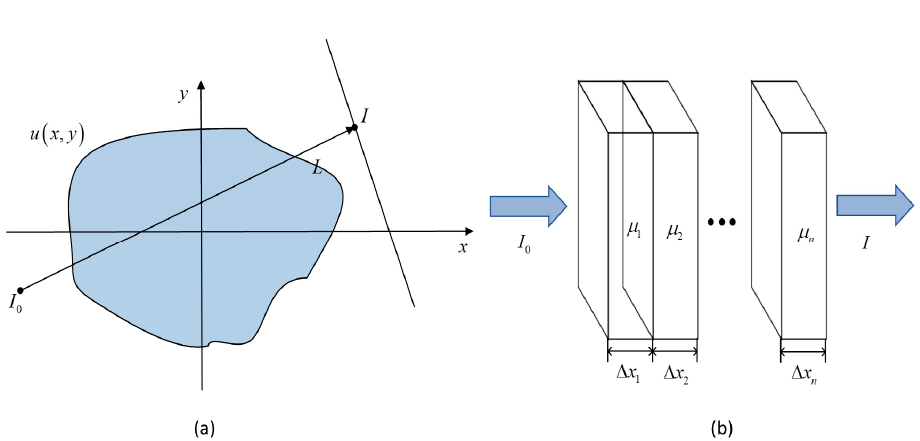
Figure 1. Schematic diagram of X-ray penetration of heterogeneous materials. ( a ) for non-uniform plane, ( b ) for discrete organization.